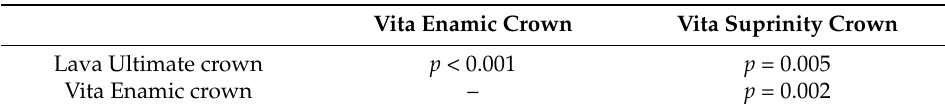
Table 4. Results of the Mann-Whitney U test comparing of the median value of the vertical loss of the natural antagonists between the tested material groups. Vita Enamic Antagonist Vita Suprinity Antagonist Lava Ultimate antagonist p = 0.019 p = 0.089 Vita Enamic antagonist – p = 0.853 2.3. Volume Loss of the Full Ceramic CAD/CAM Crowns and the Natural Antagonists The highest total occlusal abrasive wear (volume loss) of the full ceramic CAD/CAM crowns after 1,200,000 chewing cycles was in the Lava Ultimate group 4.2 μ m 3 (interquartile range 3.19–5.77 μ m 3 ),